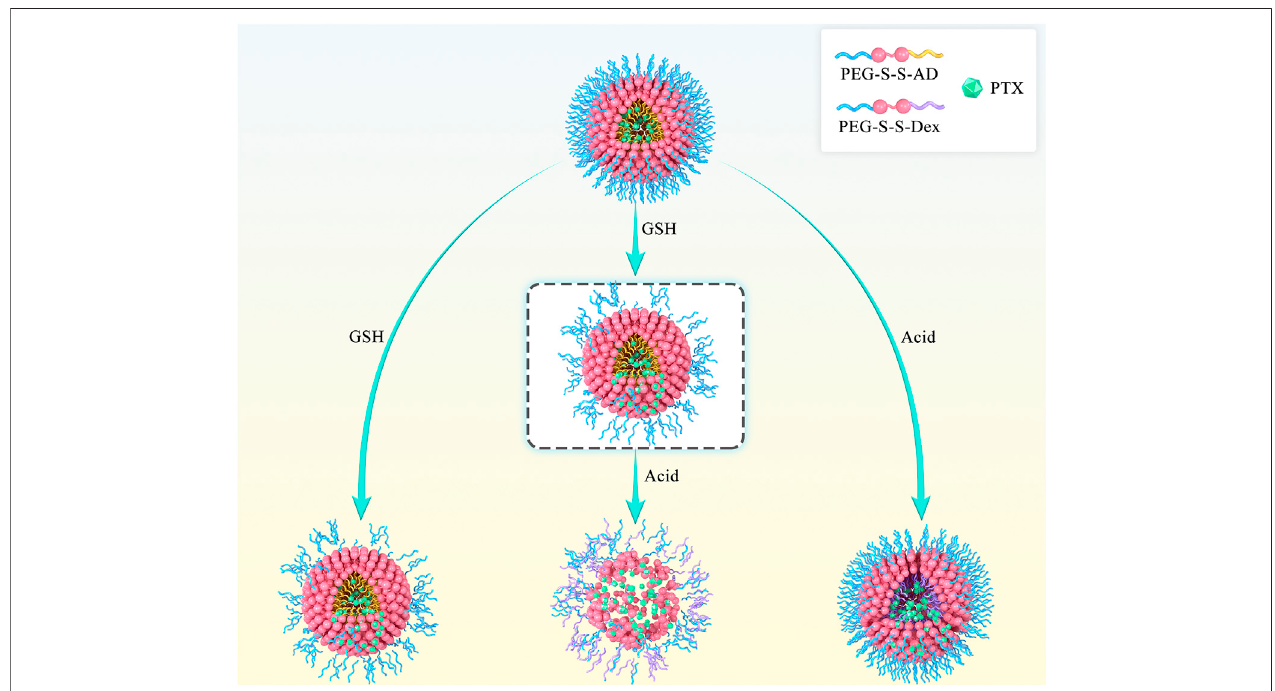
FIGURE 1 | Scheme of rapid cleavage of dual-responsive nano-medicine (PTX@PSA NPs) in the presence of glutathione and acid. Compared to the shedding of the outer PEG layer induced by the breaking of disul fi de bond in the presence ofglutathione alone and the internal expansion induced bythe change of hydrophobic AD to hydrophilic Dex in the presence of acid alone, dual-responsive PTX@PSA NPs possess a faster drug release rate.